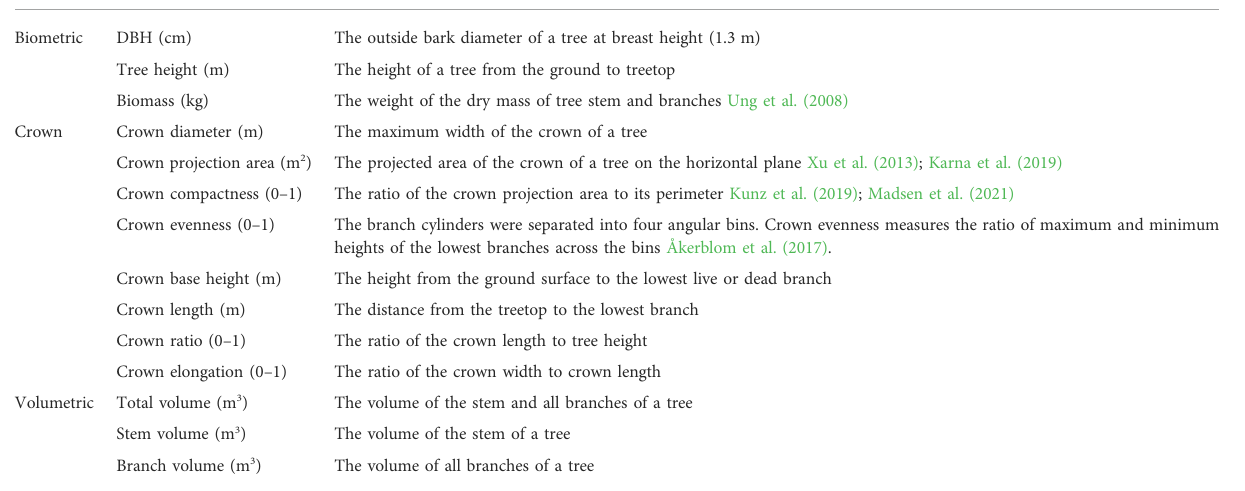
TABLE 3 The structural attributes of individual trees used in this